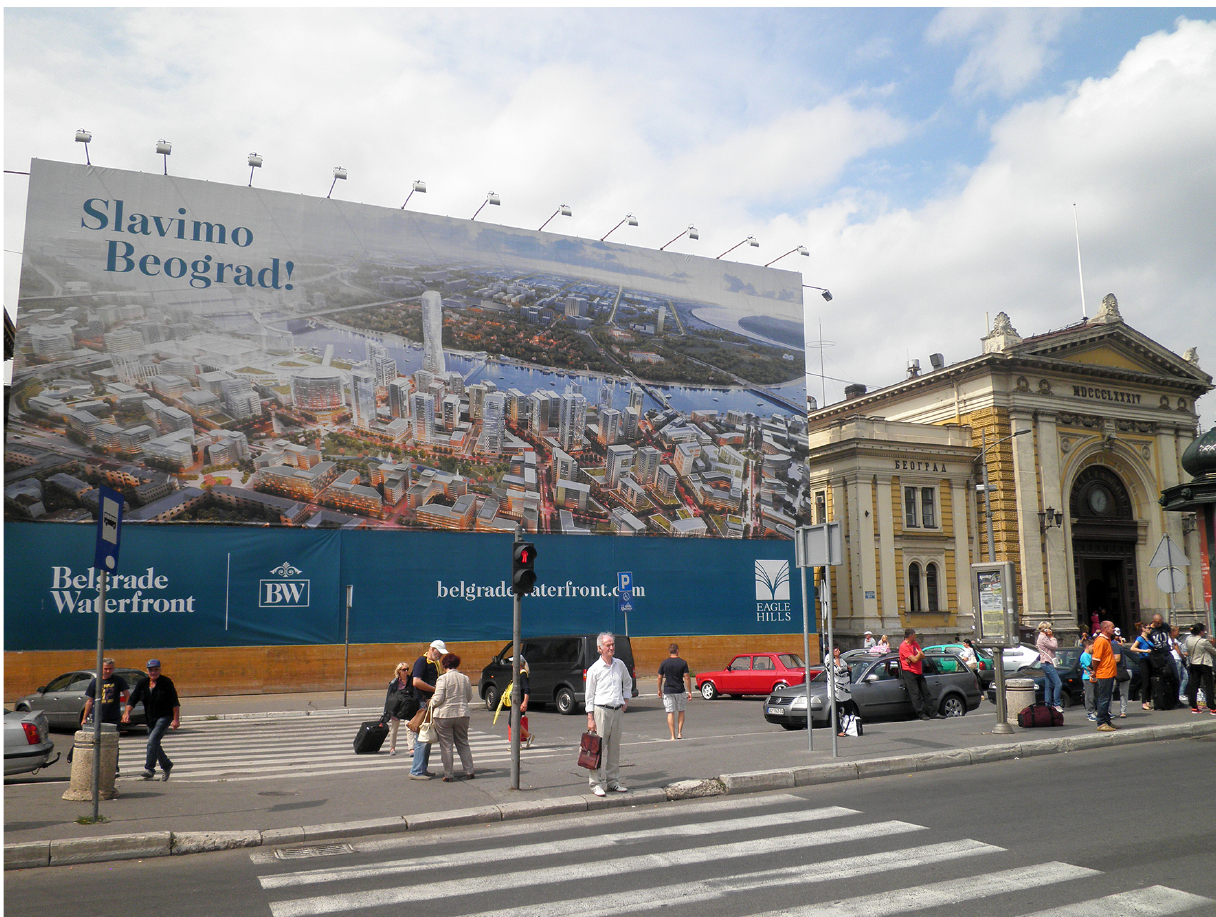
Figure 4. A billboard close to the construction site, advertising the project. Photograph by the